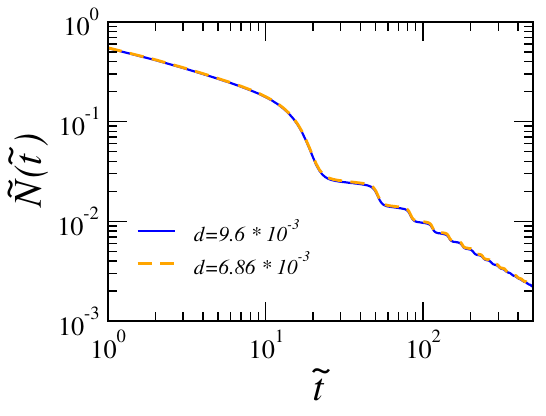
Figure 6: Comparison of the time-evolution of the normalized density ˜ N ( ˜ t ) for ω/ ˜ γ = 0.1 obtained for two different discretization of the phase space d , as indi- cated in the